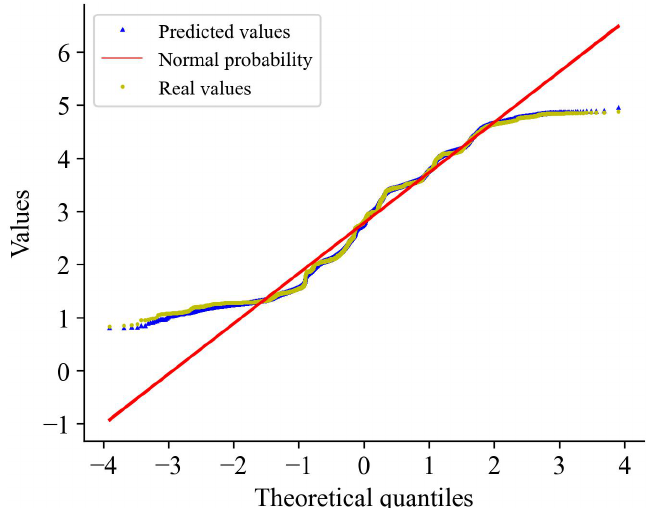
Figure 15. The QQ plot of the model prediction and actual values.